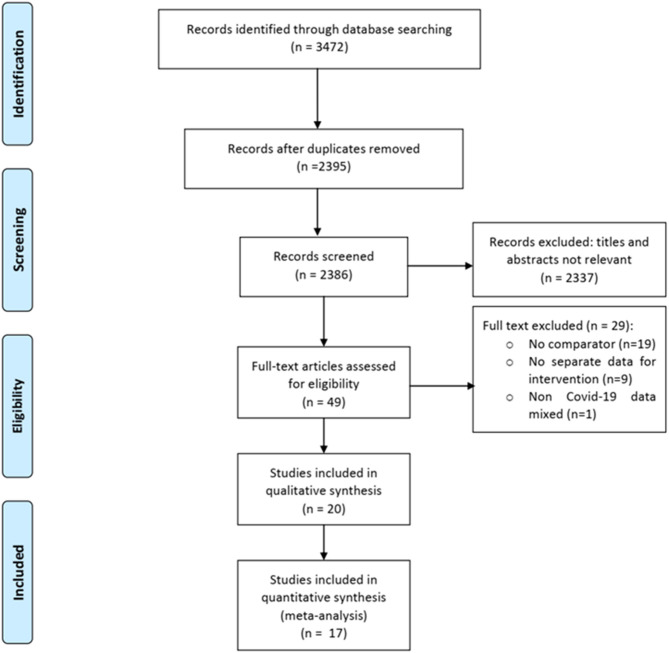
PRISMA flow diagram.